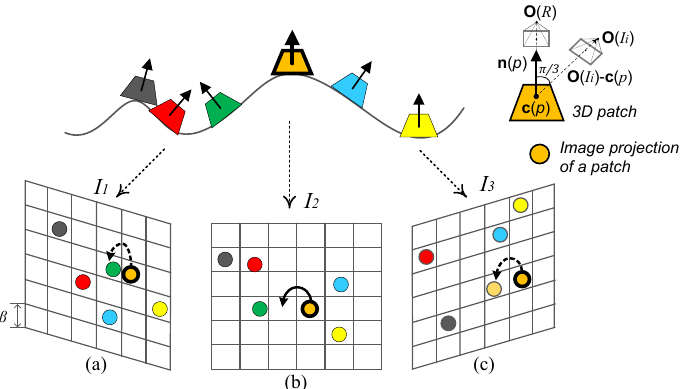
Figure 3. Illustration of patch expansion. Case ( b ) depicts that the seed patch is propagated to its neighboring cell since no similar patch occupies it. Case ( a ) and ( c ) are the non-propagation scenarios where the patch in the neighboring cell is close to or shares a high similarity value with the seed